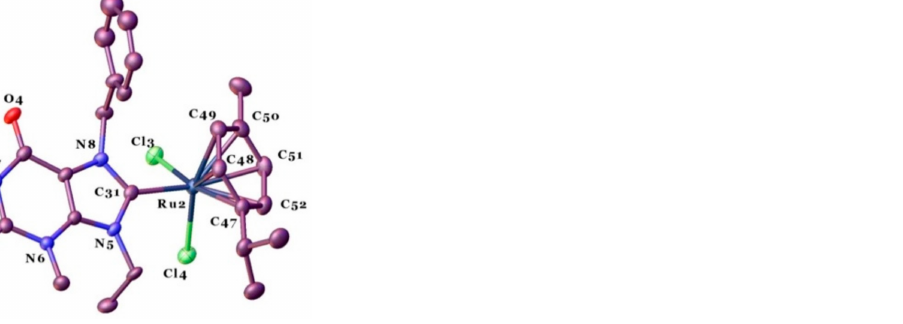
Figure 5. Molecular structure of compound 15 . Thermal ellipsoids are drawn at the 50% level. Hydrogen atoms have been omitted for